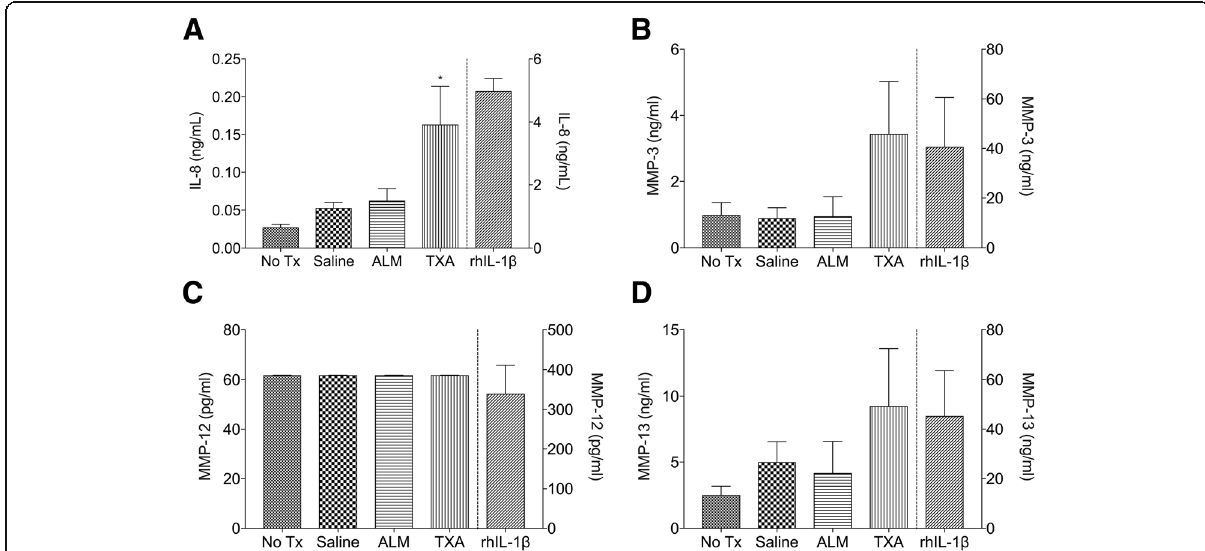
Fig. 3 Concentration of ( a ) IL-8, ( b) MMP-3, ( c ) MMP-12 and ( d ) MMP-13 in chondro-MSC cultures left untreated (culture media only) or exposed to 0.9% saline, ALM, TXA or recombinant human IL-1 β . Data is expressed as mean ± S.E.M. * P < 0.05 compared to no treatment. ALM, adenosine, lidocaine, and magnesium; IL, interleukin; MMP, matrix metalloproteinase; MSC, mesenchymal stem cells; TXA, tranexamic